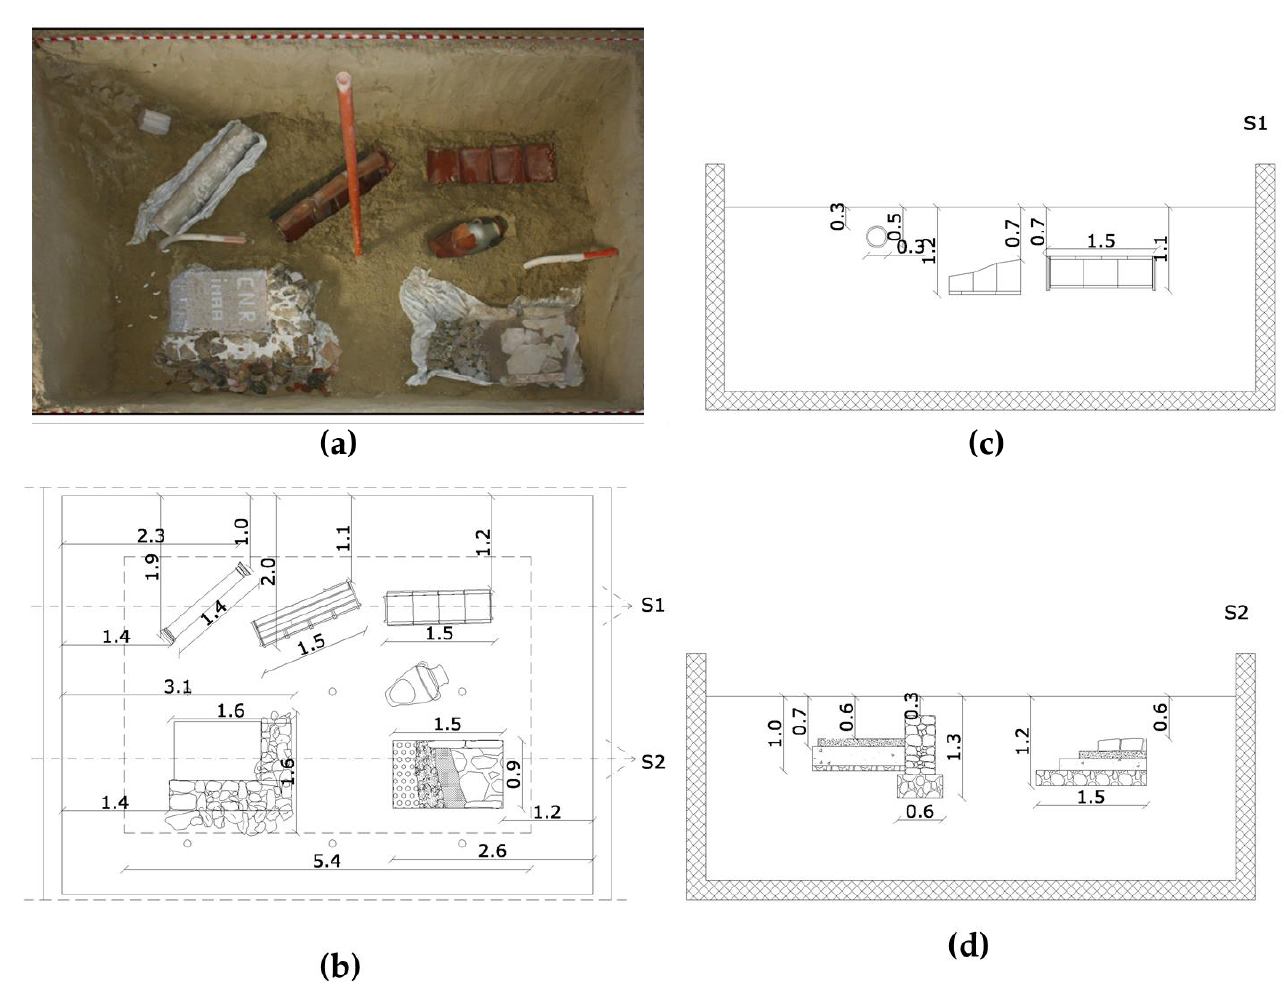
Figure 2. The archaeological framework reconstructed in the laboratory: ( a ) plan of remains ( b ) and transversal sections S1 ( c ) and S2 ( d ). The circles shown in the maps represent the positions of the piezometers and the numbers indicate the distance in meters. The pool is 12 m × 7 m × 3 m. Table 2. Electrical and em properties of the archaeological elements and background soil.